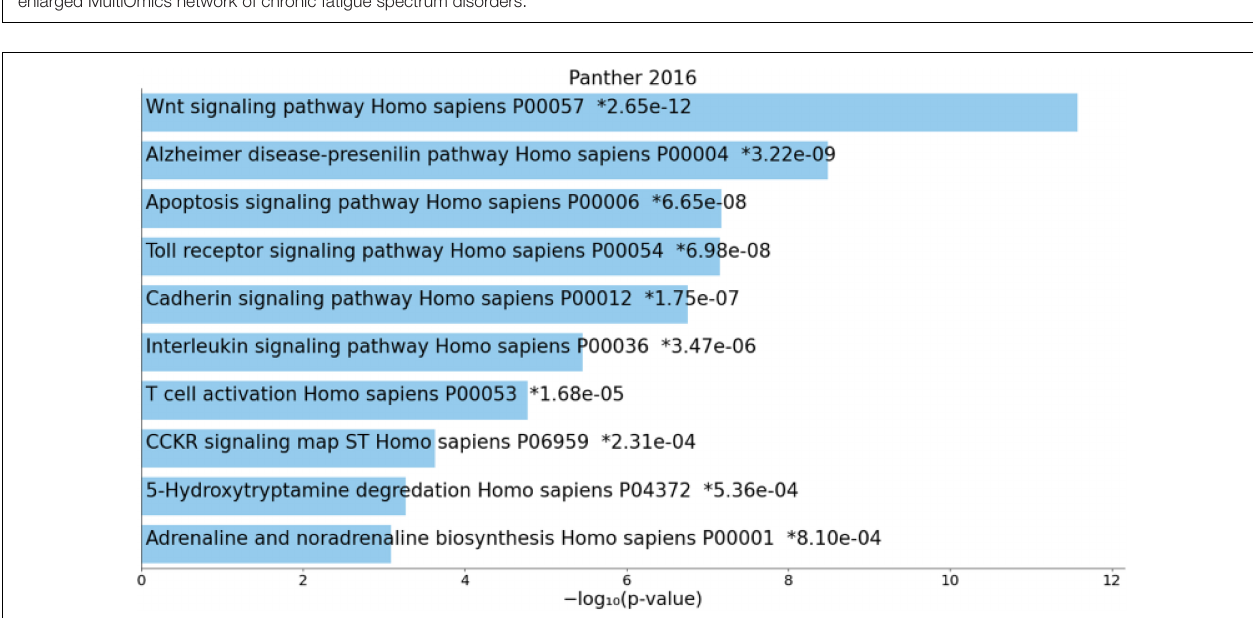
FIGURE 5 | Heatmap (top 10) of the enriched Kyoto Encyclopedia of Genes and Genomes (KEGG) terms accumulated in the differently expressed proteins of the enlarged MultiOmics network of chronic fatigue spectrum disorders.